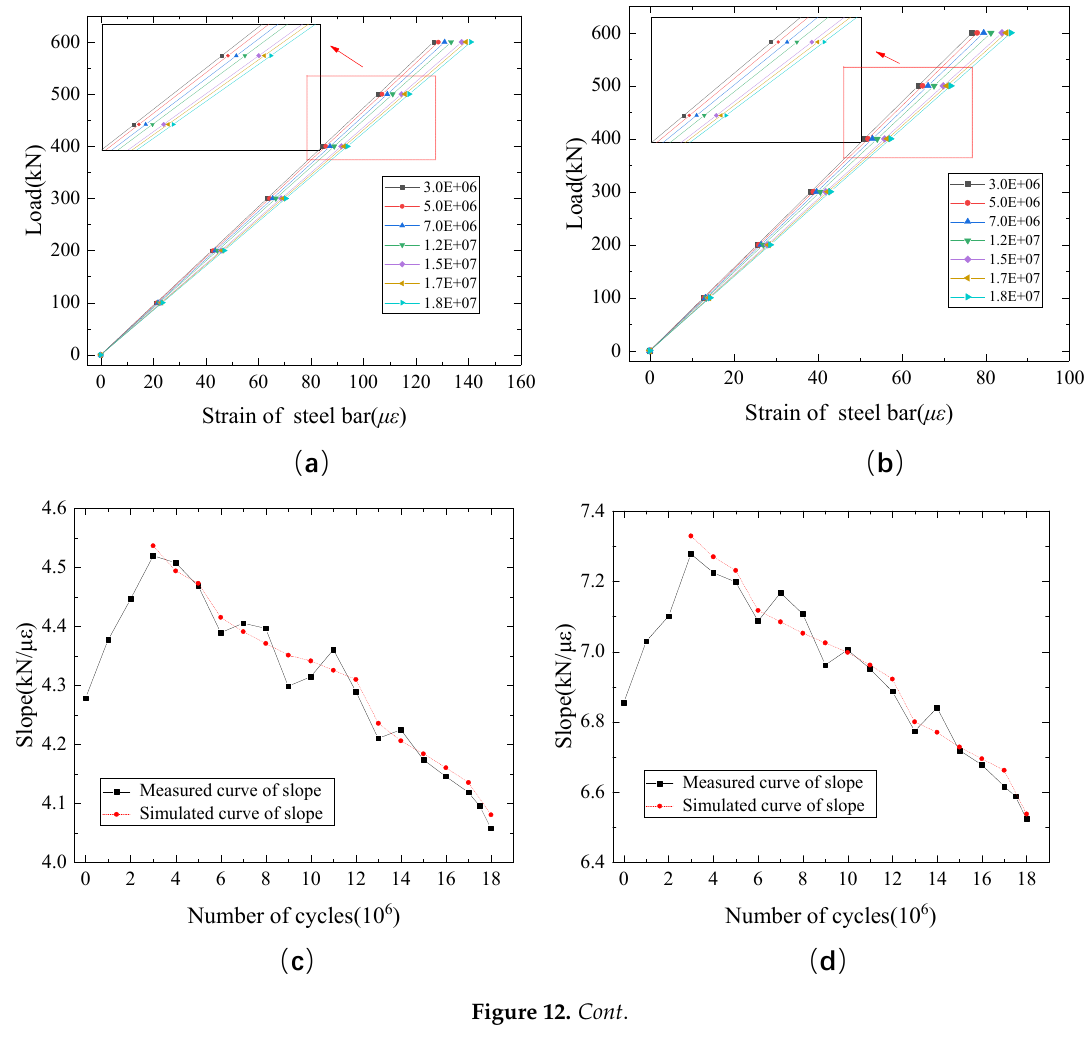
Figure 6. Load–strain curve of ordinary steel bar (a) L/2 section; (b) L/4